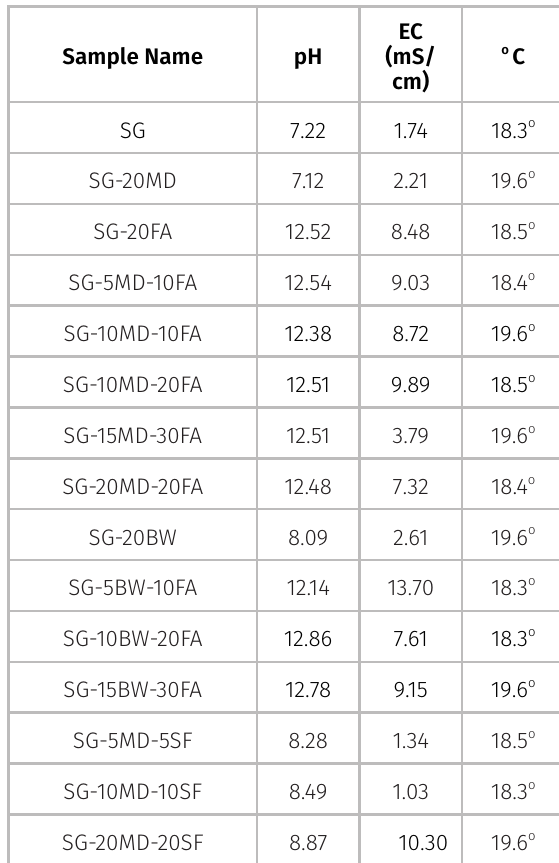
Table III. pH and EC values of